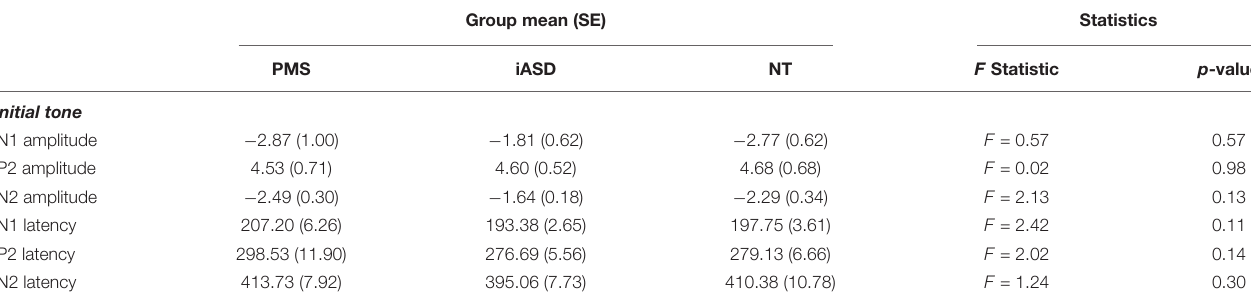
TABLE 2 | Analysis of group differences to initial